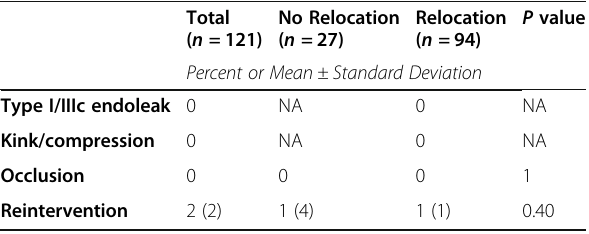
Table 3 Superior mesenteric artery (SMA) outcomes of 121 patients undergoing fenestrated endovascular aortic repair (FEVAR) using the Zenith Fenestrated AAA Endovascular® with large fenestrations for superior mesenteric artery incorporation